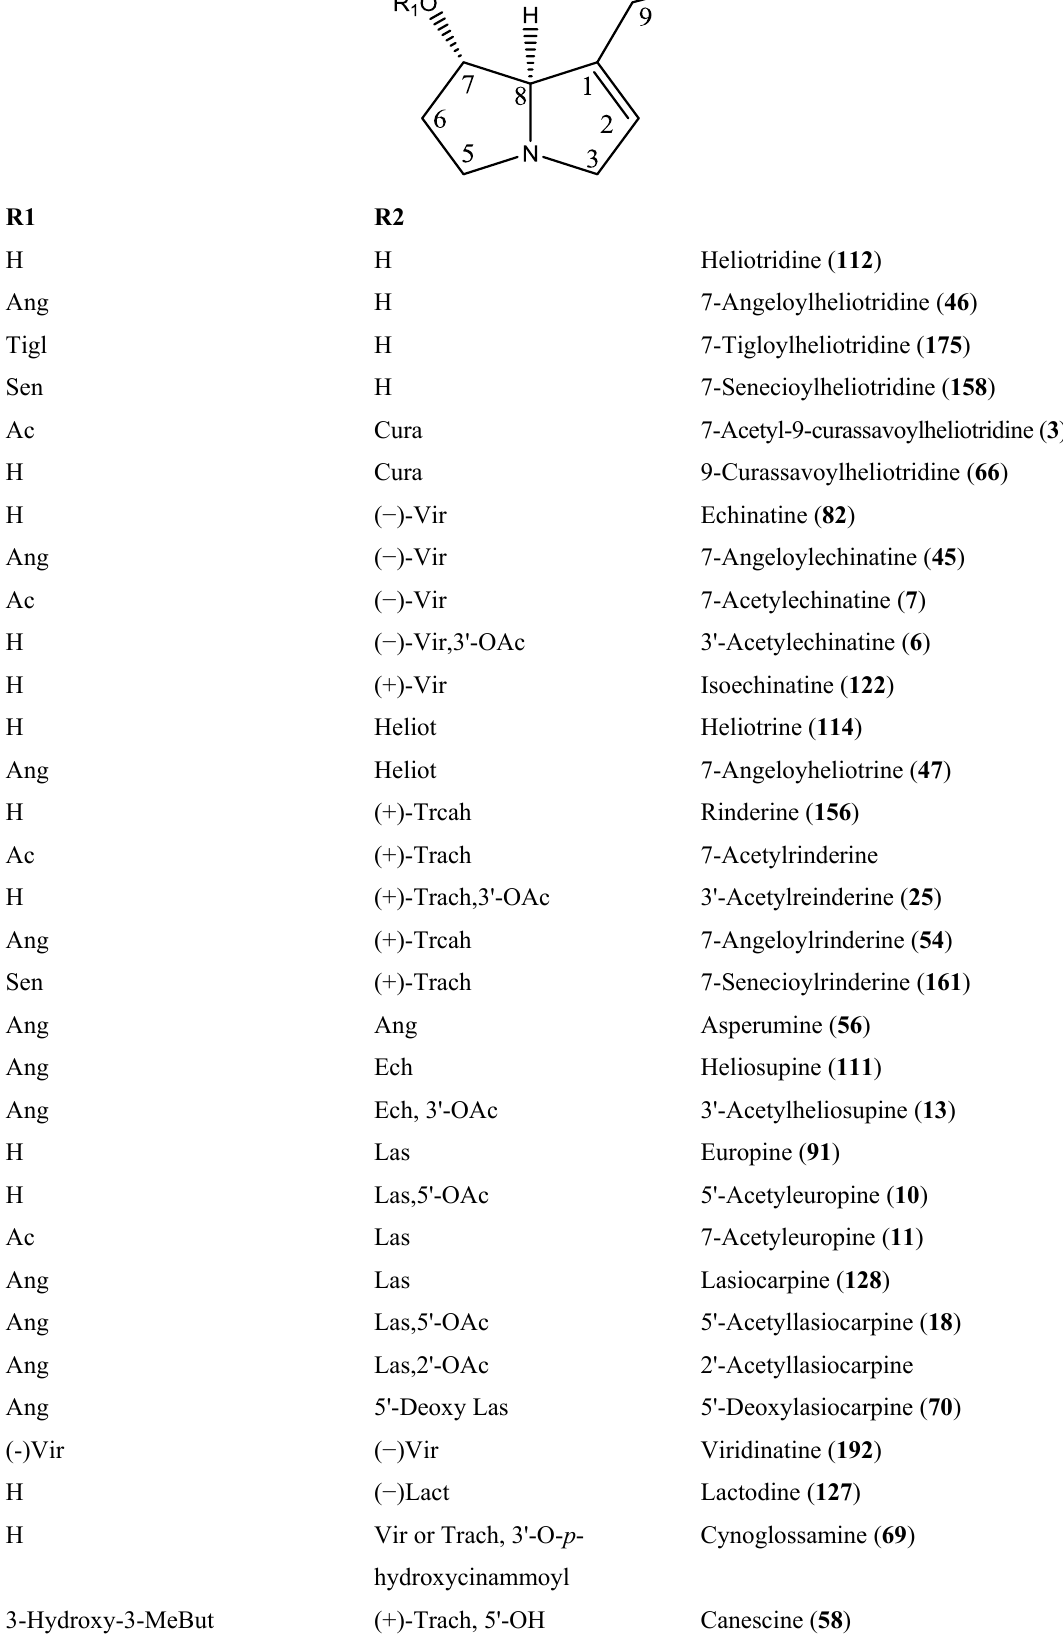
Figure 16. Pyrrolizidine alkaloid structures in Boraginaceae. Compounds are numbered as in Table